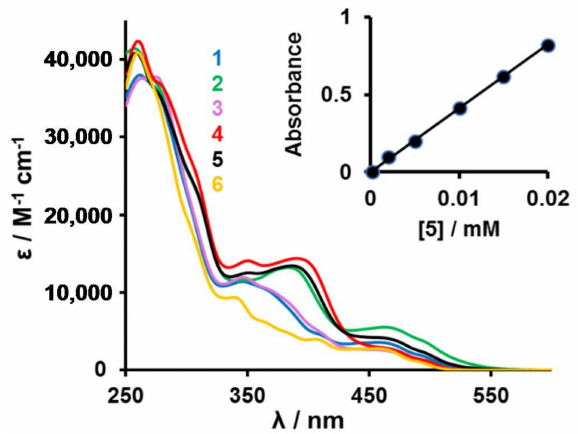
Figure 2. UV–Vis spectra of [(ppy) 2 Ir(RCOCHCOR (cid:48) )] complexes 1 (R = Fc, R (cid:48) = CH 3 , blue), 2 (R = R (cid:48) = Fc, green), 3 (R = Rc, R (cid:48) = CH 3 , purple), 4 (R = R (cid:48) = Rc, red), 5 (R = Fc, R (cid:48) = Rc, black) and 6 (R = R (cid:48) = CH 3 , orange) in CH 2 Cl 2 . Insert : The linear relationship between absorbance and concentration for complex 5 at λ = 262